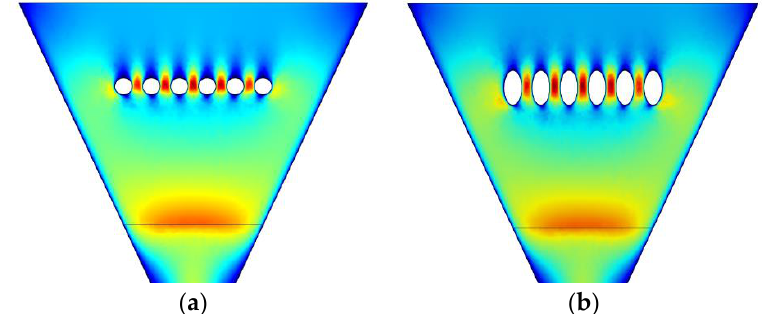
Figure 13. Velocity contour at the diffuser: ( a ) Case 2 and ( b ) Case 8.